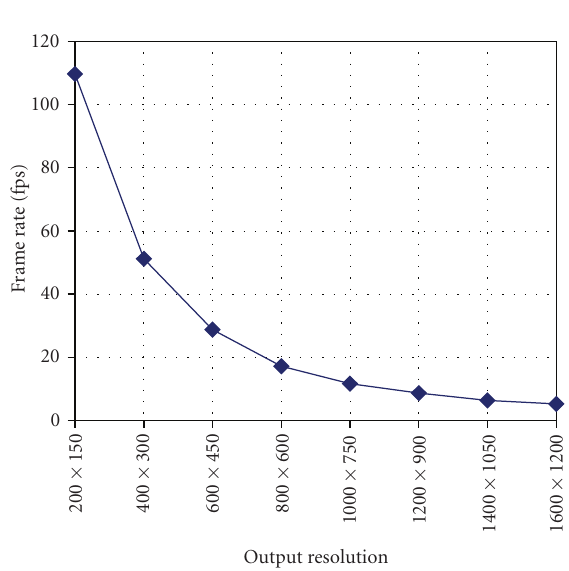
Figure 14: Frame rates obtained for di ff erent output